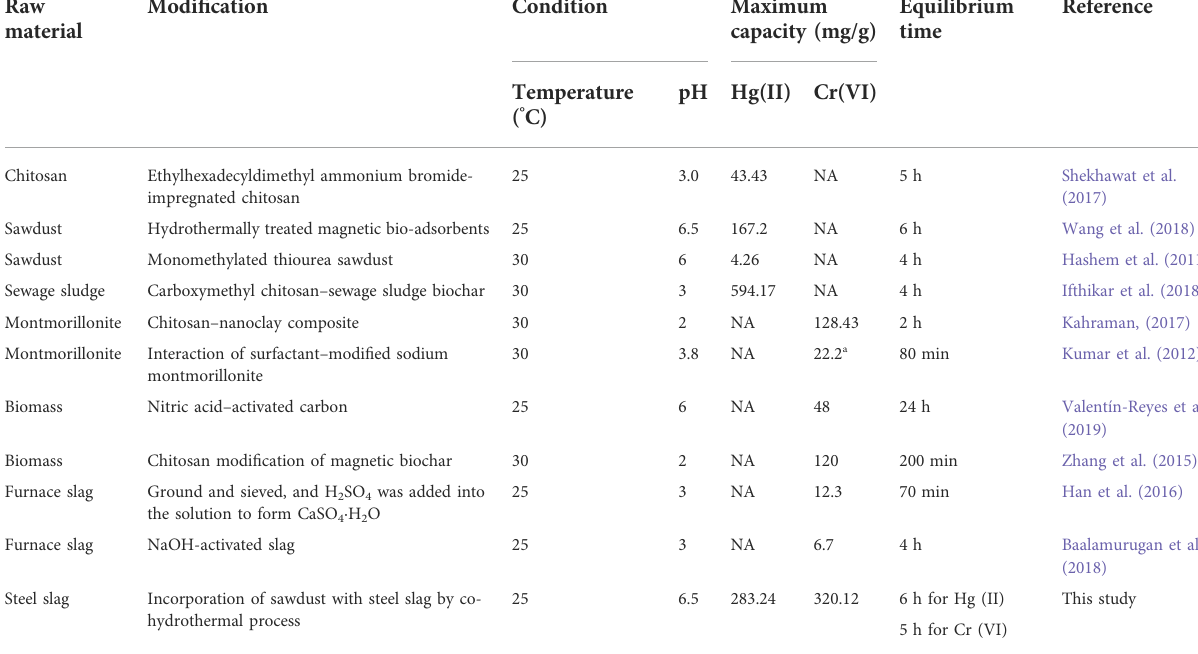
TABLE 4 Comparison of adsorption capacities of Hg(II) and Cr(VI) ions with some other functional materials. Raw material